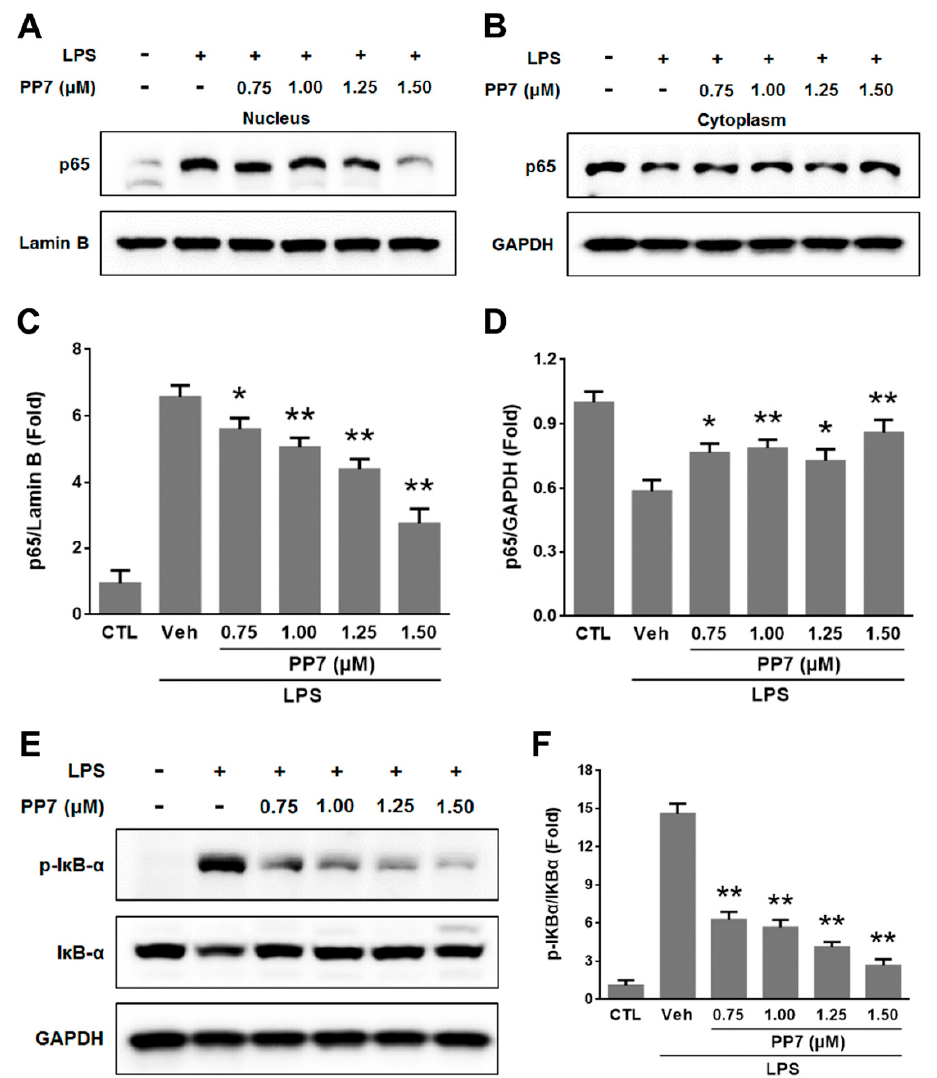
Figure 3. PP7 suppresses LPS-induced NF- κ B p65 nuclear translocation and I κ B- α degradation and phosphorylation in RAW264.7 cells. Cells were pre-treated with or without different concentrations (0.75, 1.00, 1.25, and 1.50 µ M) of PP7 for 1 h, LPS (1 µ g/mL) was then added and cells were incubated for 30 min. Western blot analysis for NF- κ B p65 in the nuclear ( A ) and cytoplasmic ( B ) extracts of RAW264.7 cells. ( C , D ) were densitometric analysis of ( A , B ). The levels of p-I κ B- α and total I κ B- α in the cytoplasm of RAW264.7 cells were determined by Western blotting ( E , F ). Values are expressed as means ± SD of triplicate experiments. * p < 0.05 and ** p < 0.01 were compared with LPS-alone group.